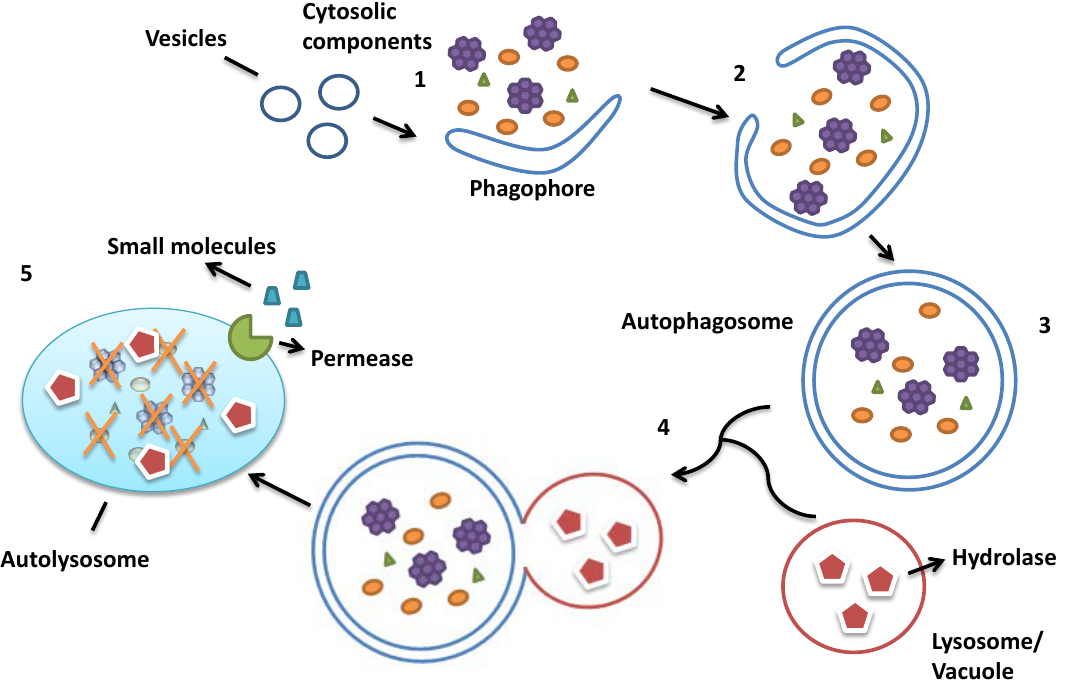
engulf the cytosolic components; (2) The expansion of the phagophore; (3) The formation of the autophagosome; (4) The fusion between the autophagosome and the lysosome; (5) The cytosolic components are digested in the autolysosome, and the resulting small molecules are released into the cytosol for reuse. (Figure is adapted from